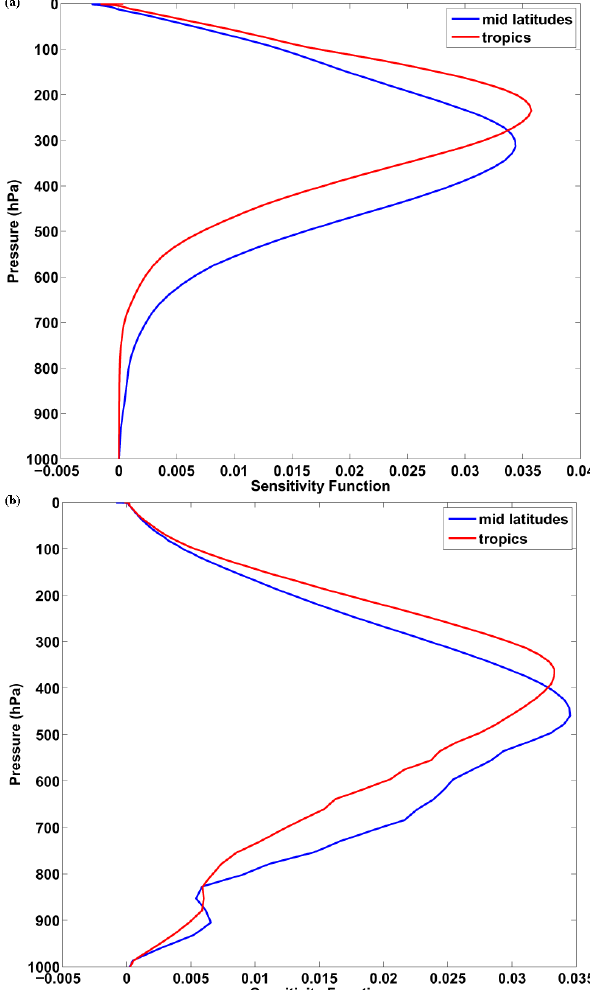
Fig. 1. Typical sensitivity functions for AIRS CO 2 retrieval from (a) a set of 15µm spectral channels (e.g., Chahine et al., 2008), and (b) a cluster of channels near the 4µm